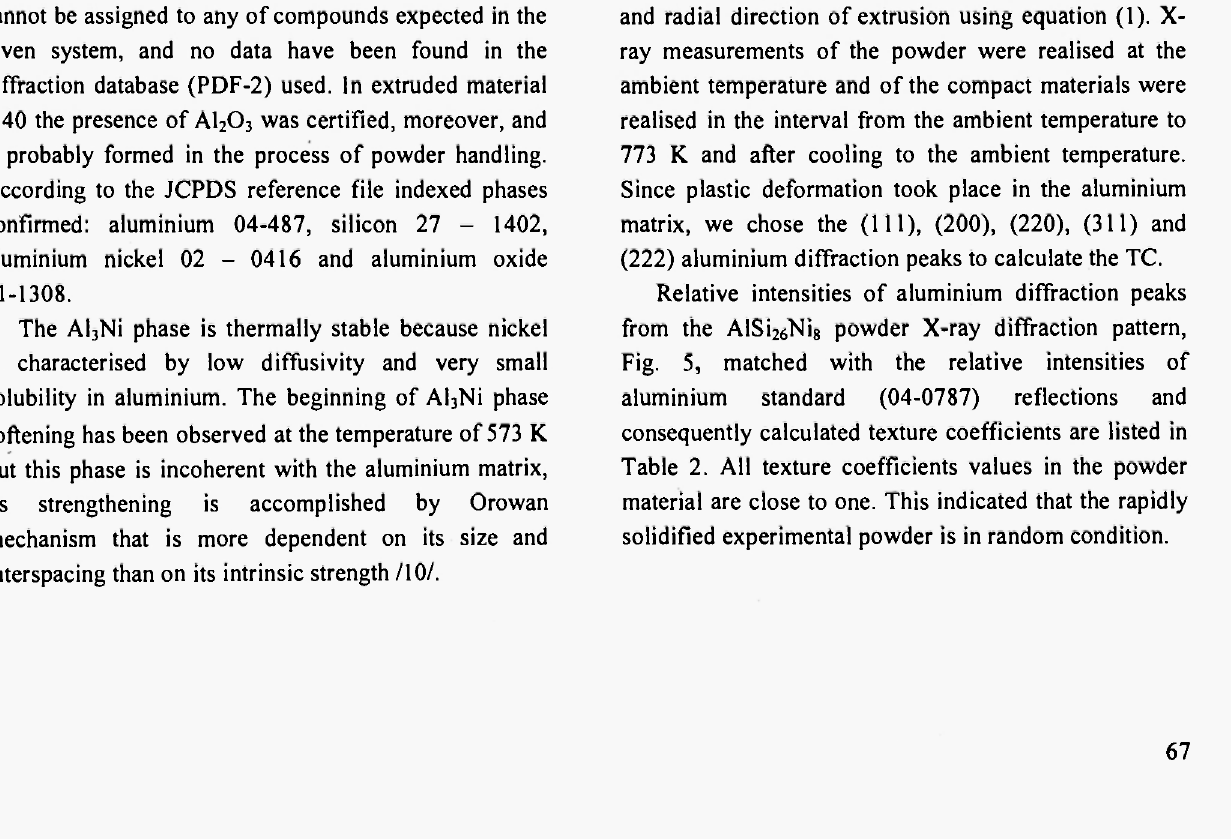
Fig. 6 a, b: X-ray diffraction patterns of the as-extruded AISi 26 Ni 8 materials at ambient temperature: